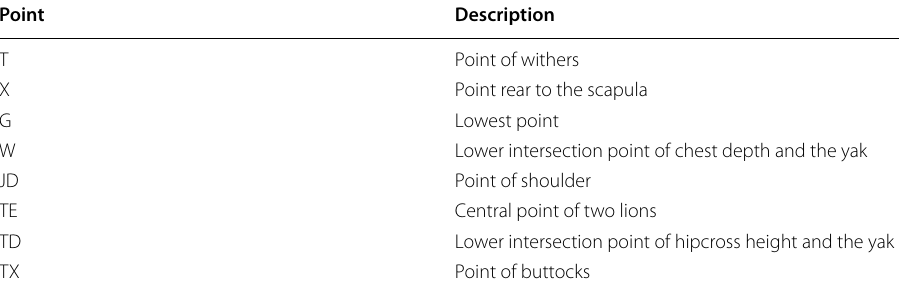
Table 2 Common morphological parameters of yaks